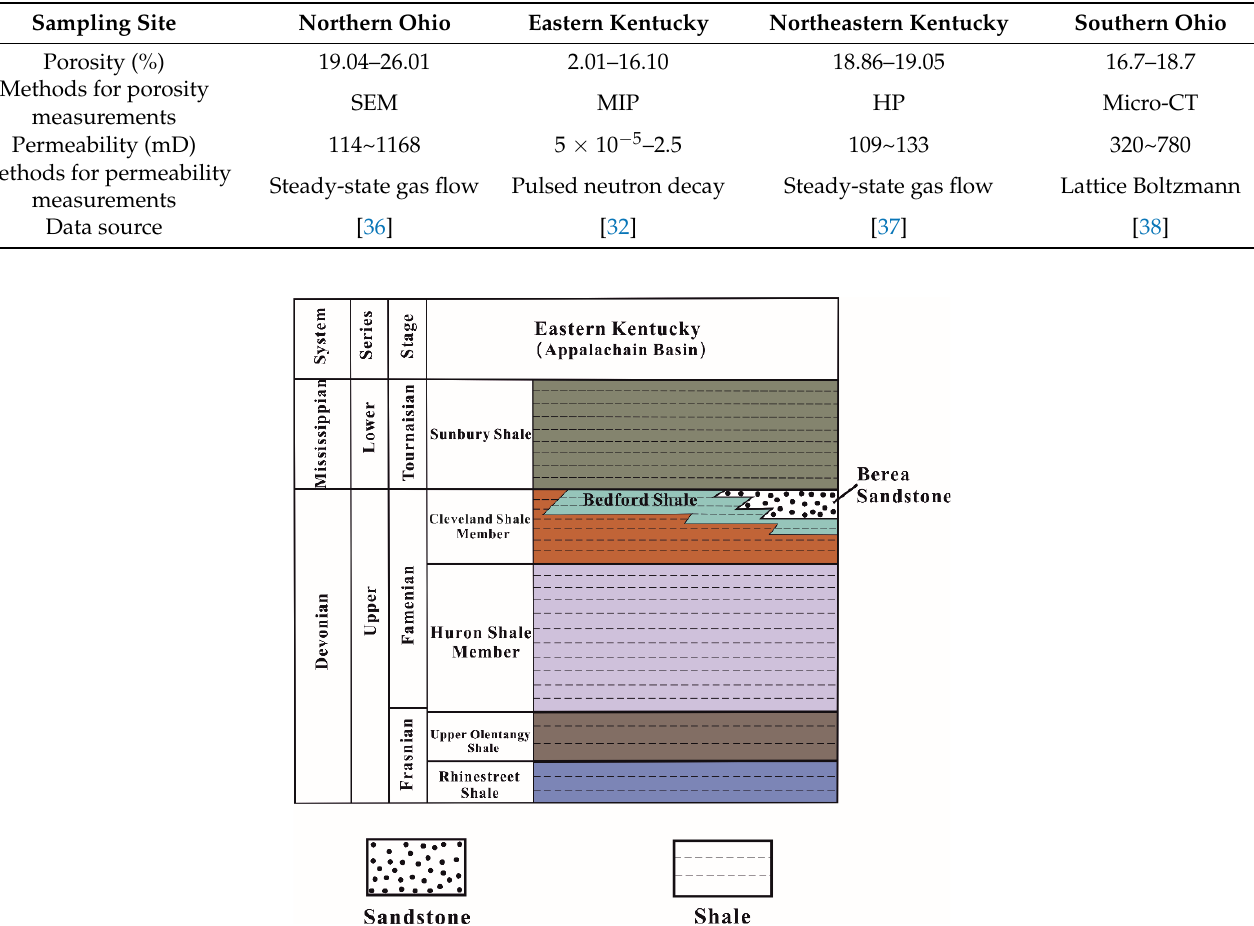
Table 1. Porosity and permeability of Berea Sandstone published in the literature.